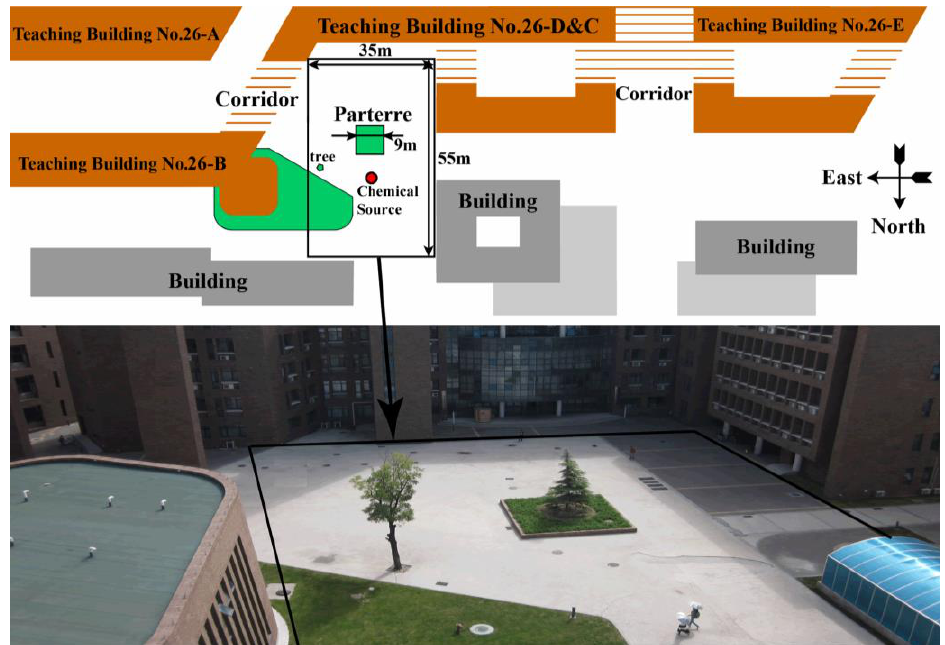
Figure 7. Plan sketch (upper) and picture (lower) of the experimental field for the O group. The trials of the O group were conducted in the small square (limited to 35 m × 55 m) on the north of Teaching Building No. 26-D&C, and there is a small garden standing about 0.4 m above the ground.